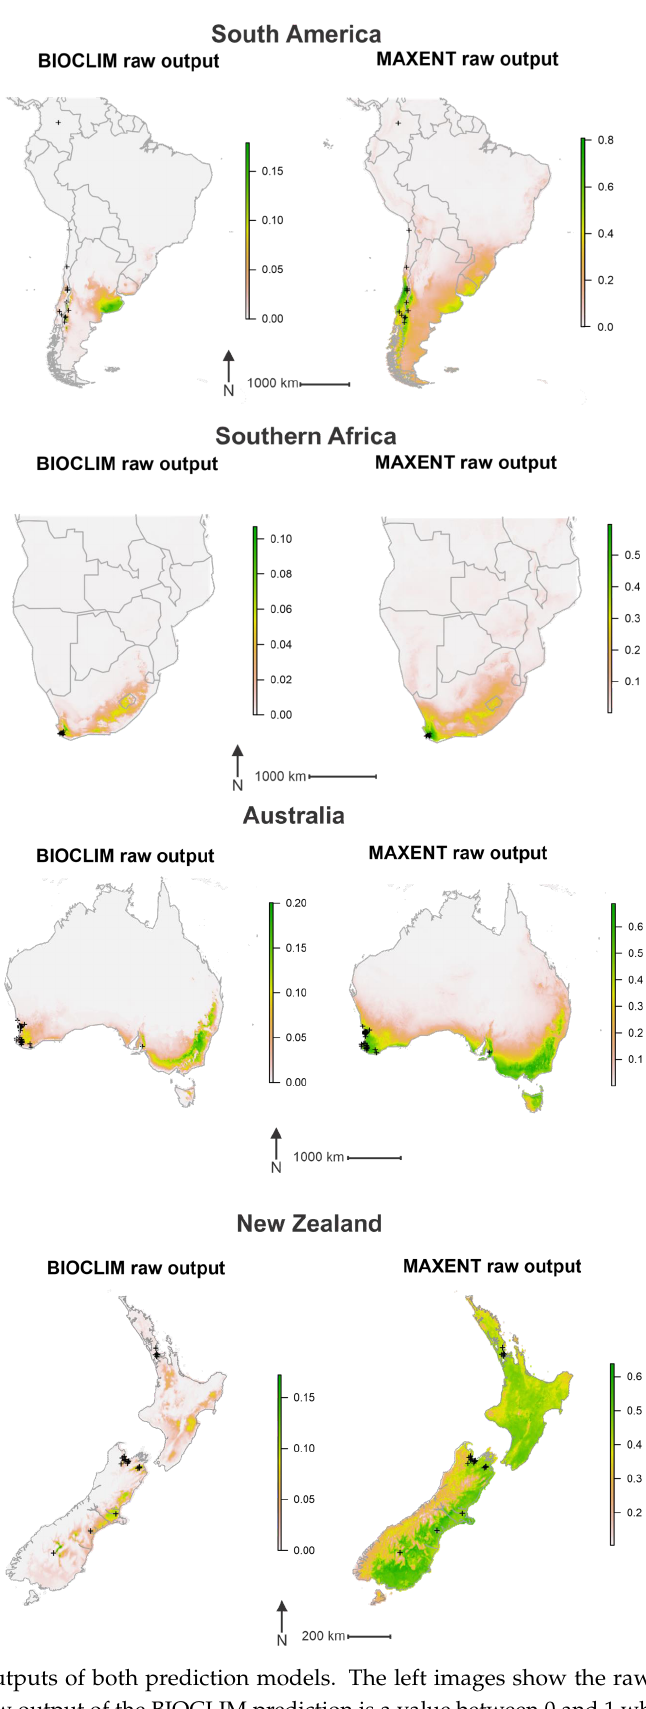
Figure 2. Raw outputs of both prediction models. The left images show the raw output given by BIOCLIM. The raw output of the BIOCLIM prediction is a value between 0 and 1 where the higher the number the more suitable the environment is. The BIOCLIM algorithm compares the environmental values of a cell to the median values of the environmental values of cells containing known occurrences of the target species. Percentile scores closest to 0.5 are most suitable so values over this are subtracted from 1. The resulting score is multiplied by 2 to get a final value between 0 and 1 [30]. The right images show the raw output given by MAXENT where the value is an approximate probability that the species will be present given the local environmental conditions [31,46]. The black crosses indicate known occurrences of P. dominula .